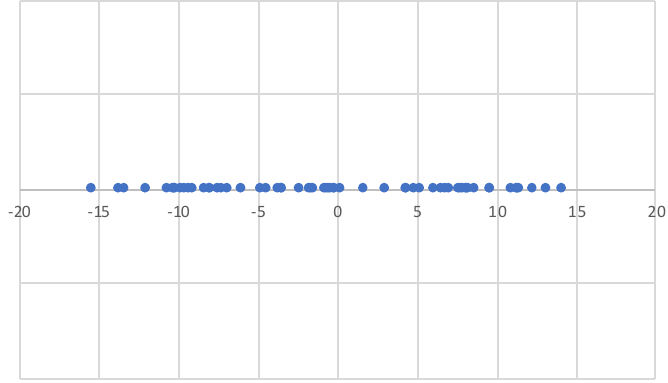
Figure 2. One-dimensional